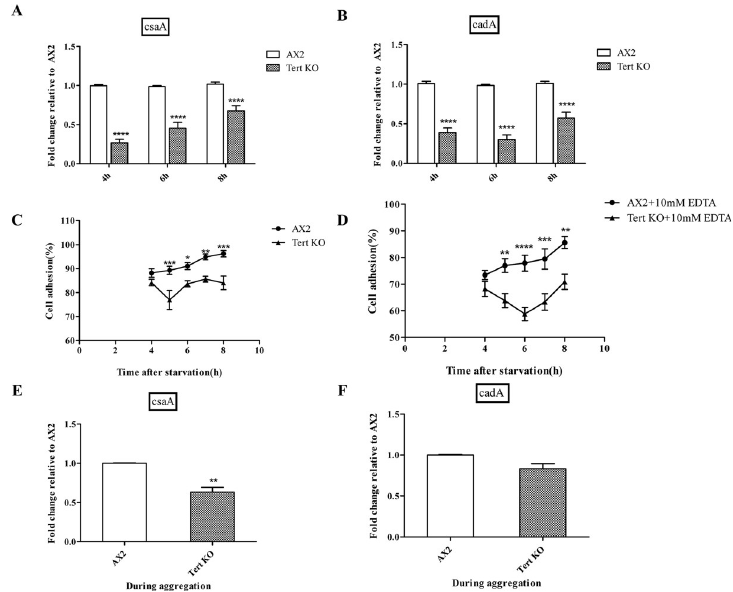
Fig 14. Disruption of tert affects cell adhesion. qRT-PCR of (A) csaA and (B) cadA . rnlA was used as mRNA amplification control. Wild-type and tert KO cells were starved in Sorensen phosphate buffer at 150 rpm and 22˚C. Samples were collected at the start of the assay and at one-hour time points after 4 h of starvation. Percentage of cell adhesion plotted over time. (C) EDTA resistant cell-cell adhesion, (D) EDTA sensitive cell-cell adhesion. Level of significance is indicated as � p < 0.05, �� p < 0.01, ��� p < 0.001, and ���� p < 0.0001. (E) csaA levels and (F) cadA levels during aggregation; (n =